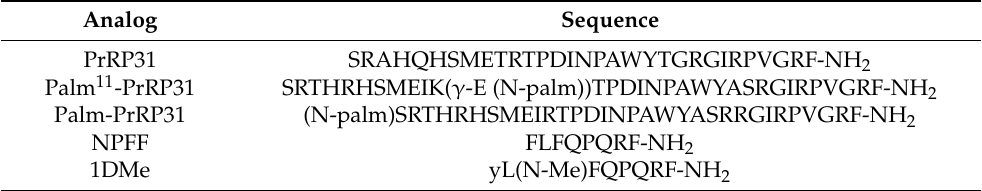
Table 1. Structures of human prolactin-releasing peptide 31 (PrRP31), neuropeptide FF (NPFF) and its analogs. Analog SRAHQHSMETRTPDINPAWYTGRGIRPVGRF-NH 2